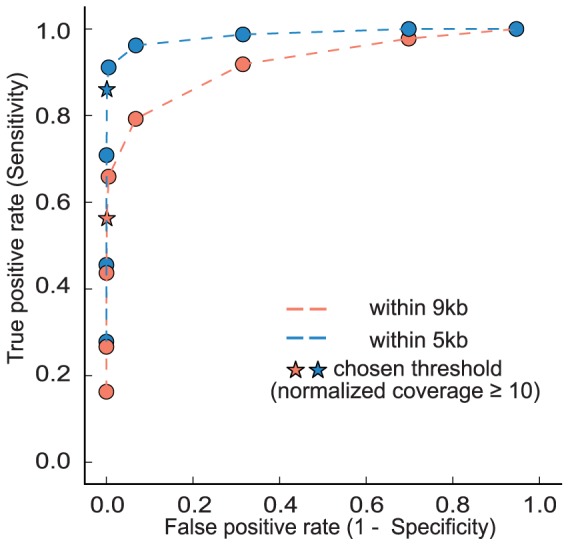
Performance analysis to determine enriched regions.Receiver operating characteristic (ROC) curves are shown with varying thresholds of normalized fold change, using within-9 kb or within-5 kb bins from target sites, respectively, as positives. Values shown in Table S2.